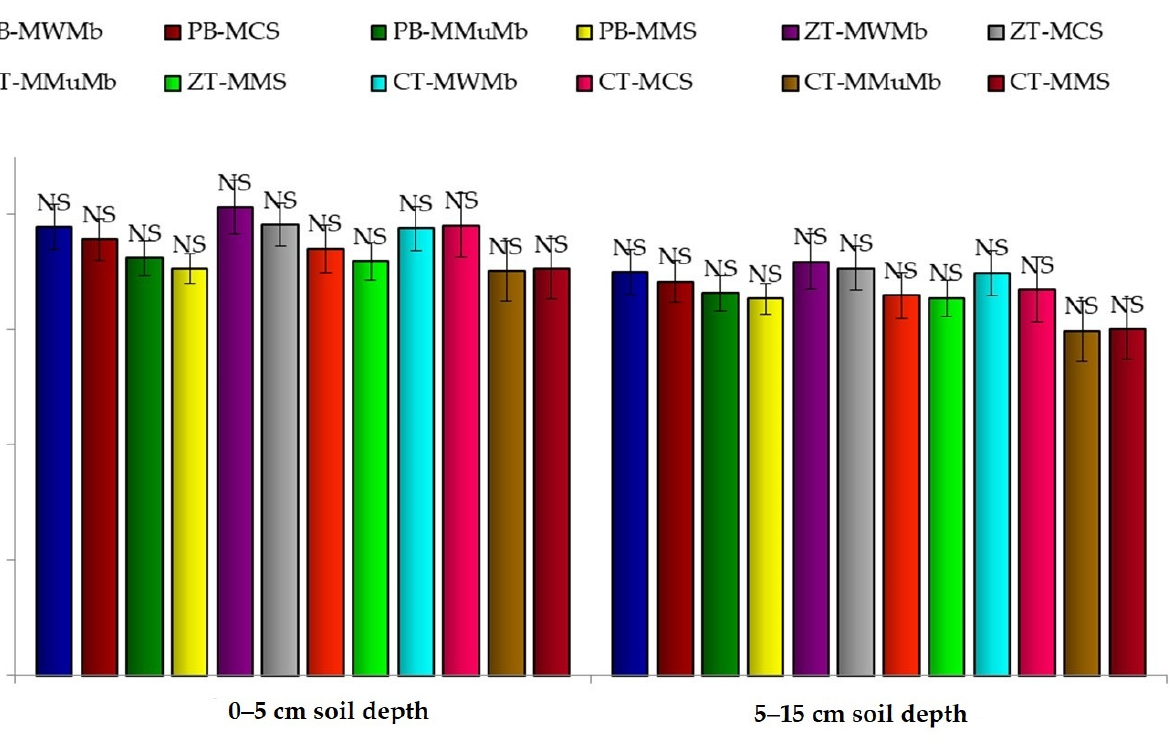
Figure 2 . Effect of long-term tillage practices and maize-based crop rotation on total P (mg kg –1 ) content at different soil depths. NS: Non-significant.